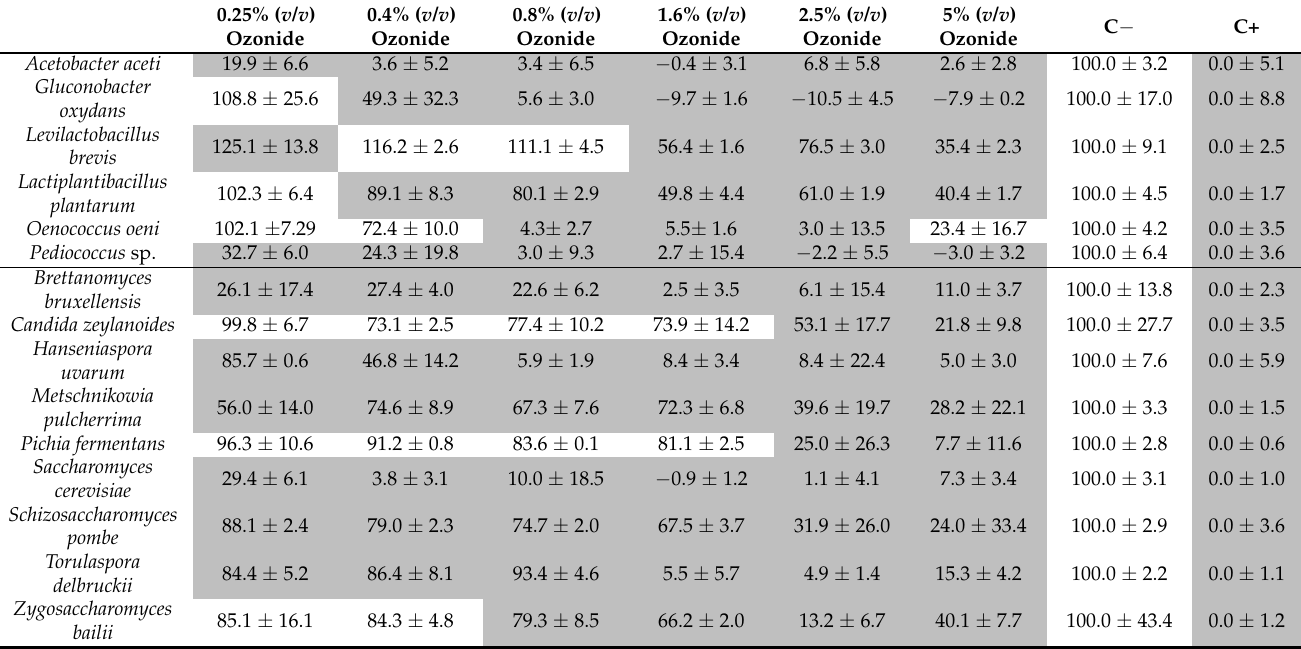
led to a statistically significant increased optical density compared to the negative control (C − ) (Table S4). With oleic acid supplementation, Pediococcus sp. showed the clearest reduction in OD 600 compared to control samples. It remained stable between 86.4 ± 8.9% and 85.4 ± 9.1% at concentrations of 0.4% ( v / v ) to 2.5% ( v / v ) oleic acid and decreased to 18.7 ± 2.7% at a concentration of 5% ( v / v ) oleic acid (Table S4). Yet, the OD 600 of Pediococcus sp. was always lower for ozonide supplementation compared to the same concentration of oleic acid, indicating a higher sensitivity towards the ozonized compound (Table 3). The ozonized oleic acid preparation applied in the vineyard had a concentration of 0.8% ( v / v ). In the liquid culture-based efficacy analyses, ozonide supplementations up to this concentration had no significant effect on the OD 600 of L. brevis, Candida zeylanoides and Pichia fermentans. Nevertheless, culture densities of C. zeylanoides and P. fermentans showed a concentration-dependent decrease at ozonide concentrations below 1.6% ( v / v ). In contrast, low concentrations of ozonide seemed to favor the growth of L. brevis liquid cultures (Table 3). Acetobacter aceti, Pediococcus sp. , S. cerevisiae and B. bruxellensis showed the highest sensitivity towards the ozonized oleic acid with an OD 600 below 50% at the lowest ozonide concentration of 0.25% ( v / v ). Negative relative optical densities, as in the case of S. cerevisiae treated with 1.6% ( v / v ) ozonide (Table 3, Figure 1), resulted from the normalization of the OD 600 to C − (100%) and C+ (0%), as described in Petit et al. (2021) [41]. This normalization was conducted to simplify comparison of the sensitivities towards the treatment between the organisms. Negative values did not deviate statistically significant from the C+ in any case. Table 3. In vitro efficacy analysis of ozonized oleic acid. Values significantly deviating from the corresponding C − ( p < 0.05) are